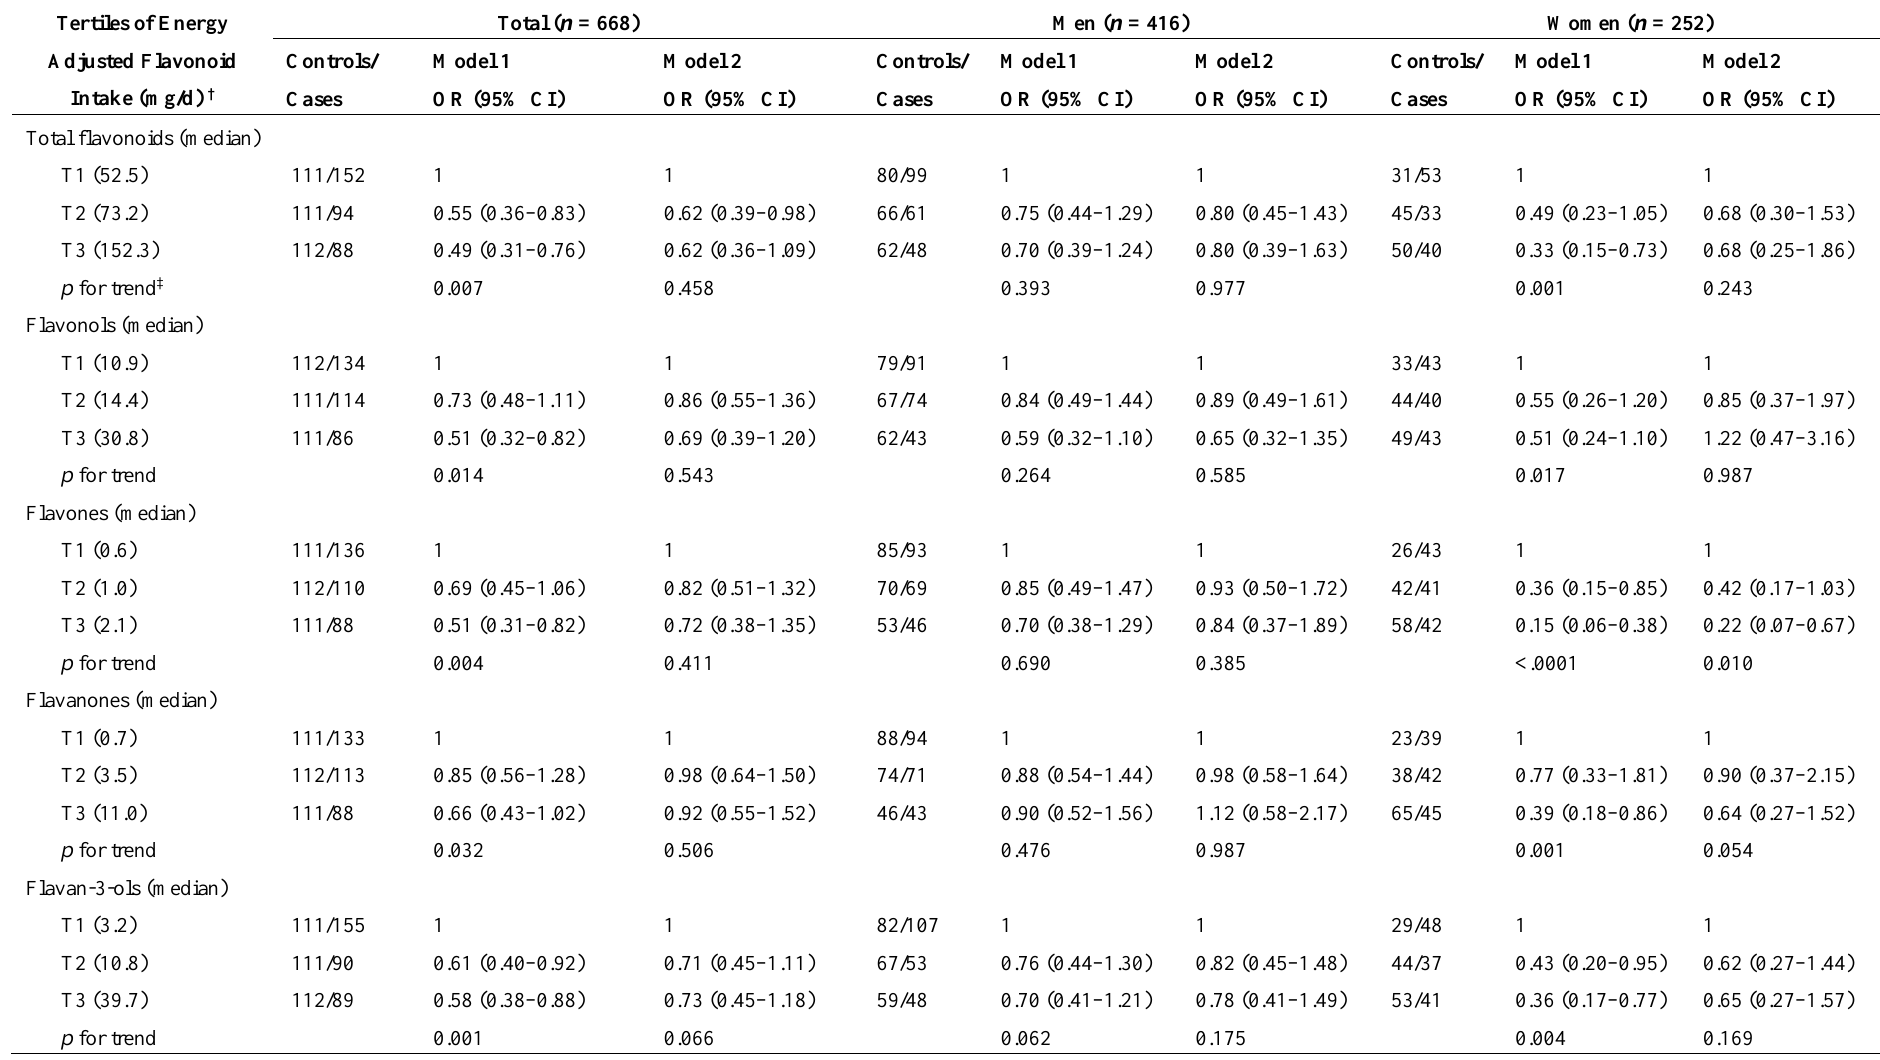
Table 2. ORs and 95% CIs of gastric cancer by tertiles of dietary